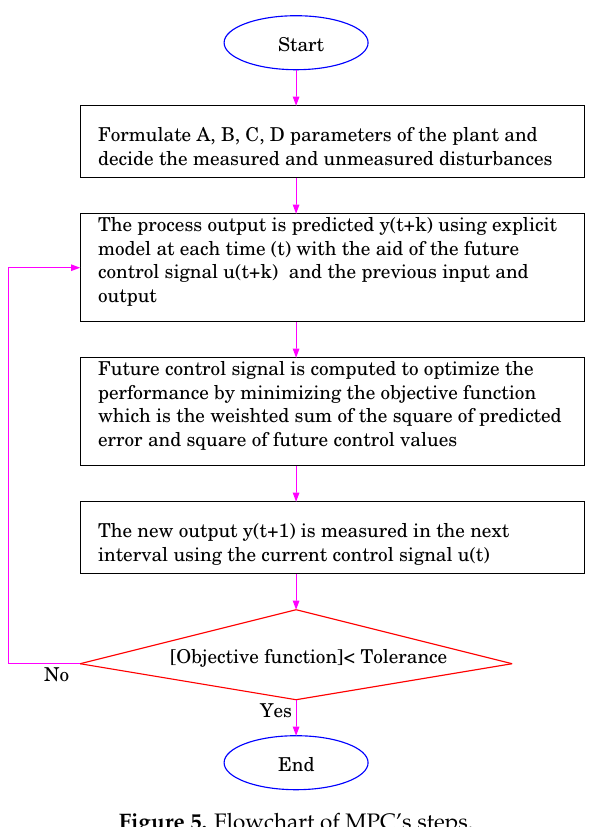
Figure 5. Flowchart of MPC’s